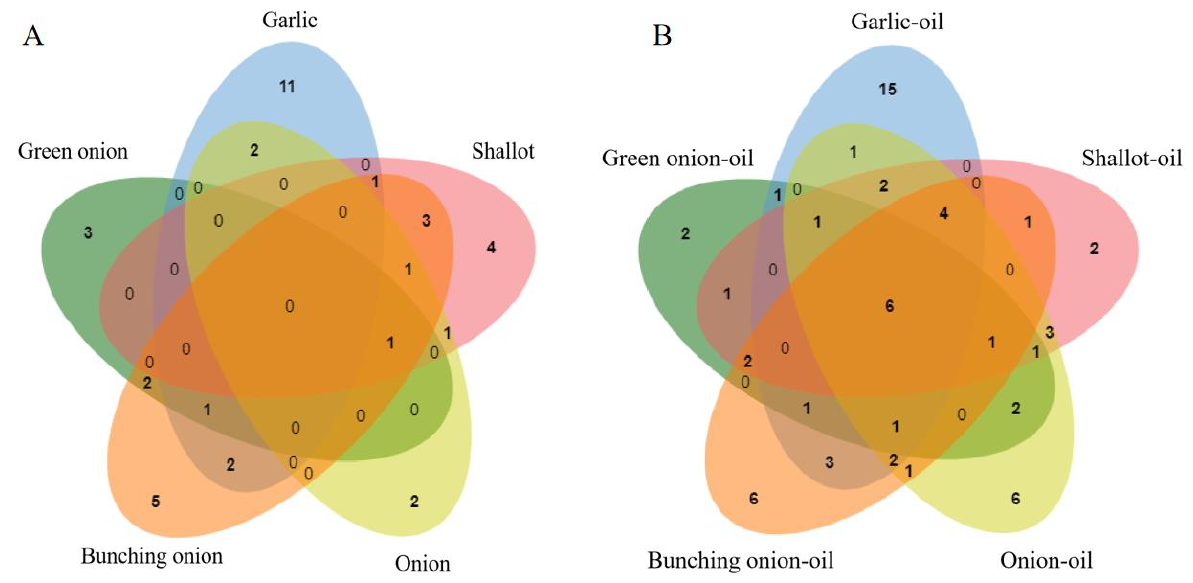
Figure 2. The Venn diagram of aroma substances identified in gas chromatography- olfactometry (GC-O) analysis in fresh Allium plants ( A ) and fried Allium oils ( B ). Note: the numbers in the graph indicate the number of compounds.